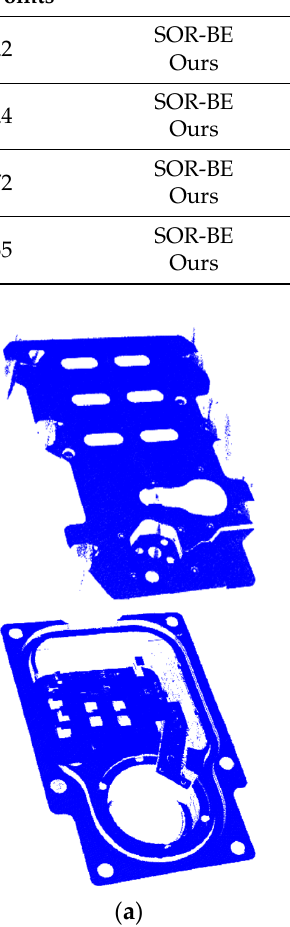
Figure 7. Boundary extraction result from different point clouds based on two methods. ( a ) Input point clouds; ( b ) Extraction results with SOR-BE method; ( c ) Extraction results with our method. Table 1. Comparison between boundary extraction results of two methods .